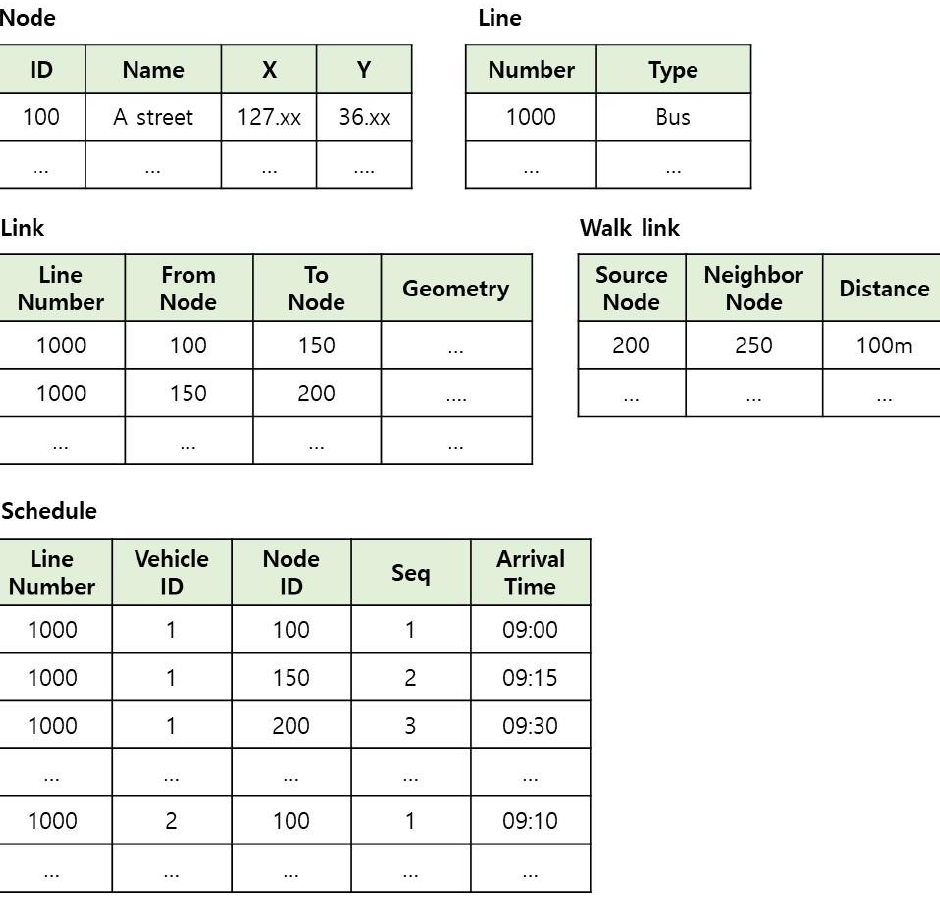
Figure 2. Data tables of a public transport network.